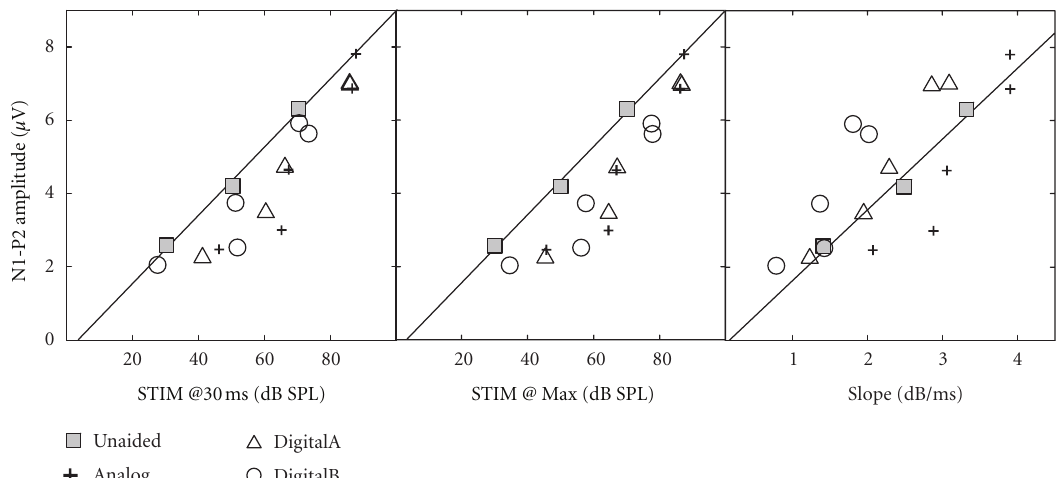
Figure 7: Group mean SCP amplitude from Marynewich et al. [11] as a function of three acoustic parameters: stimulus level at 30 ms (left panel), maximum stimulus level (middle panel), and onset slope (right panel) for unaided and 3 hearing-aid conditions. The fit line is the linear regression for the unaided